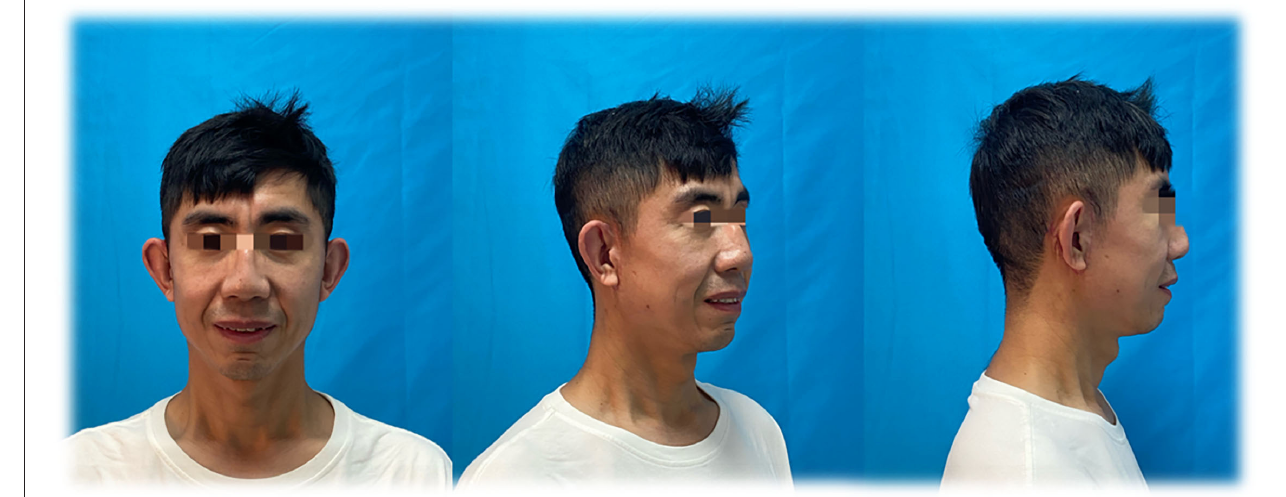
FIGURE 2 | Post-operative frontal and oblique views for 5 months after the